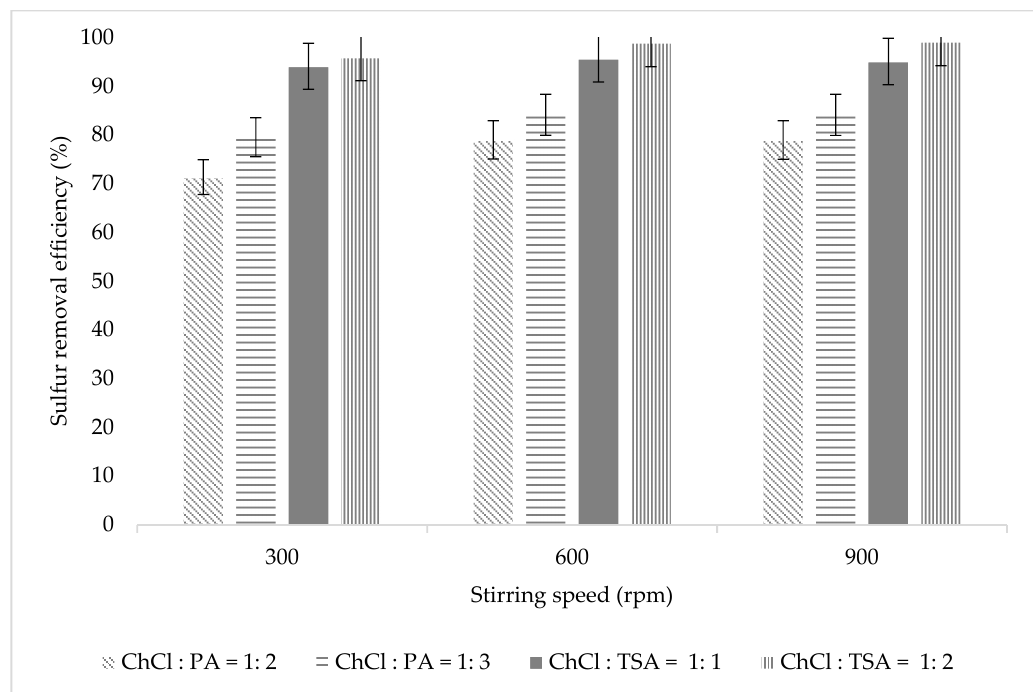
Figure 4. The effect of stirring speed on the sulfur removal efficiency (0.01 g Cu-Fe/TiO 2 , H 2 O 2 as oxidant with ratio to DBT of 1:2, 10 mL of 100 ppm model oil (DBT), room temperature, and EIL to model oil ratio of 1:5).